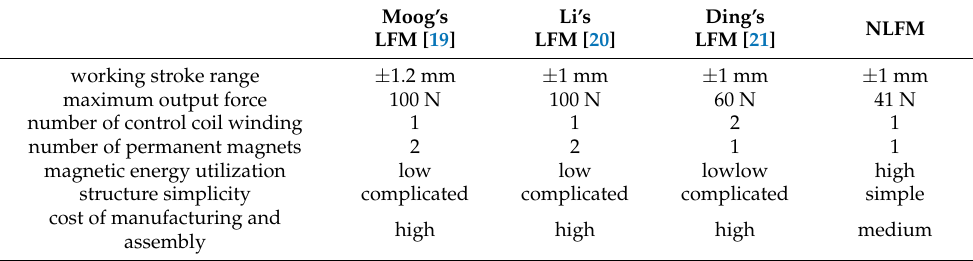
Table 9. Comparison between the NLFM and existing